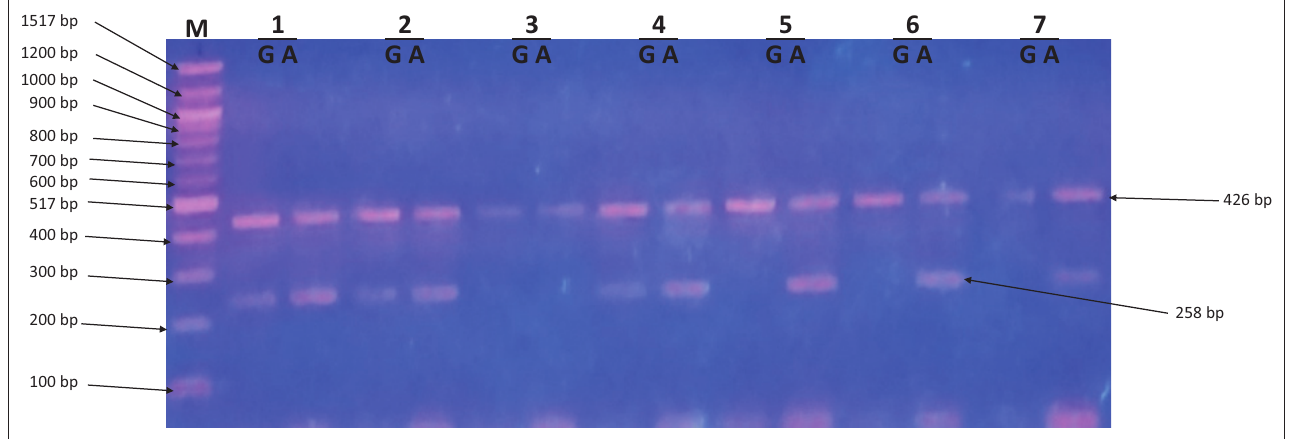
FIGURE 2: Amplicons for interleukin-10 -1082 G/A single nucleotide polymorphism. Lane M shows 100 base pair (bp) molecular marker. The 426 bp fragments correspond to the internal control. The 258 bp fragments were specific for G and A alleles of interleukin-10 -1082 G/A single nucleotide polymorphisms. Lanes labelled 1, 2 and 4 show heterozygous GA genotype. Lanes labelled 5, 6 and 7 show homozygous AA